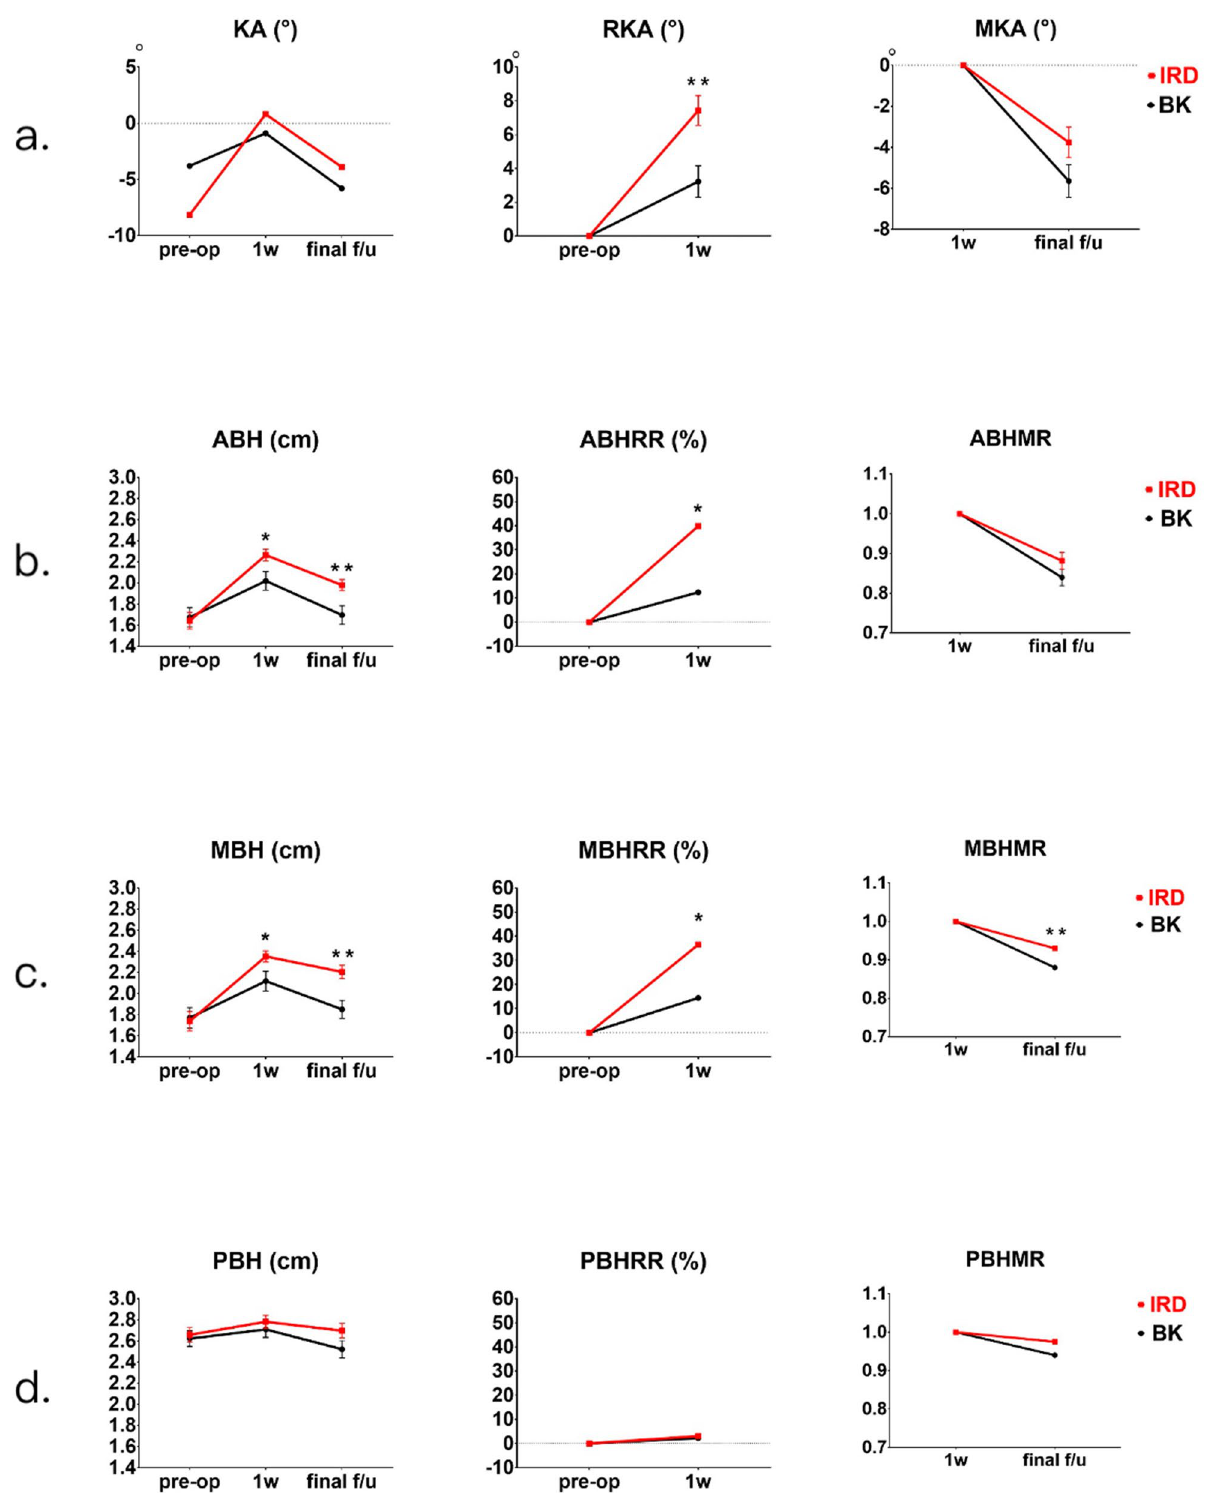
Figure 4. Comparisons of radiological outcomes between the KP with IRD group and the BK group. ( a ) Comparisons of KA at pre-operation, 1-week post-operation, and final follow-up. ( b ) Comparisons of ABH at pre-operation, 1-week post-operation, and final follow-up. ( c ) Comparisons of MBH at pre-operation, 1-week post-operation, and final follow-up. ( d ) Comparisons of PBH at pre-operation, 1-week post-operation, and final follow-up. ( IRD kyphoplasty with intravertebral reduction device, BK kyphoplasty with balloon, KA kyphotic angle, RKA restoration of kyphotic angle, MKA maintenance of kyphotic angle, ABH anterior body height, MBH middle body height, PBH posterior body height, RR restoration ratio, MR maintenance ratio) ( p value summary: * p < 0.05, ** p ≤